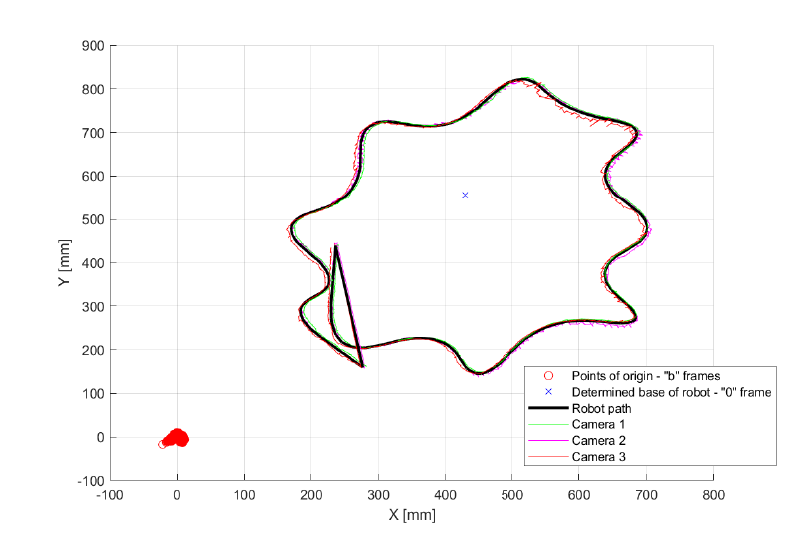
Figure 9. Paths measured by cameras in comparison with the real robot path of experiment A, xy plane.